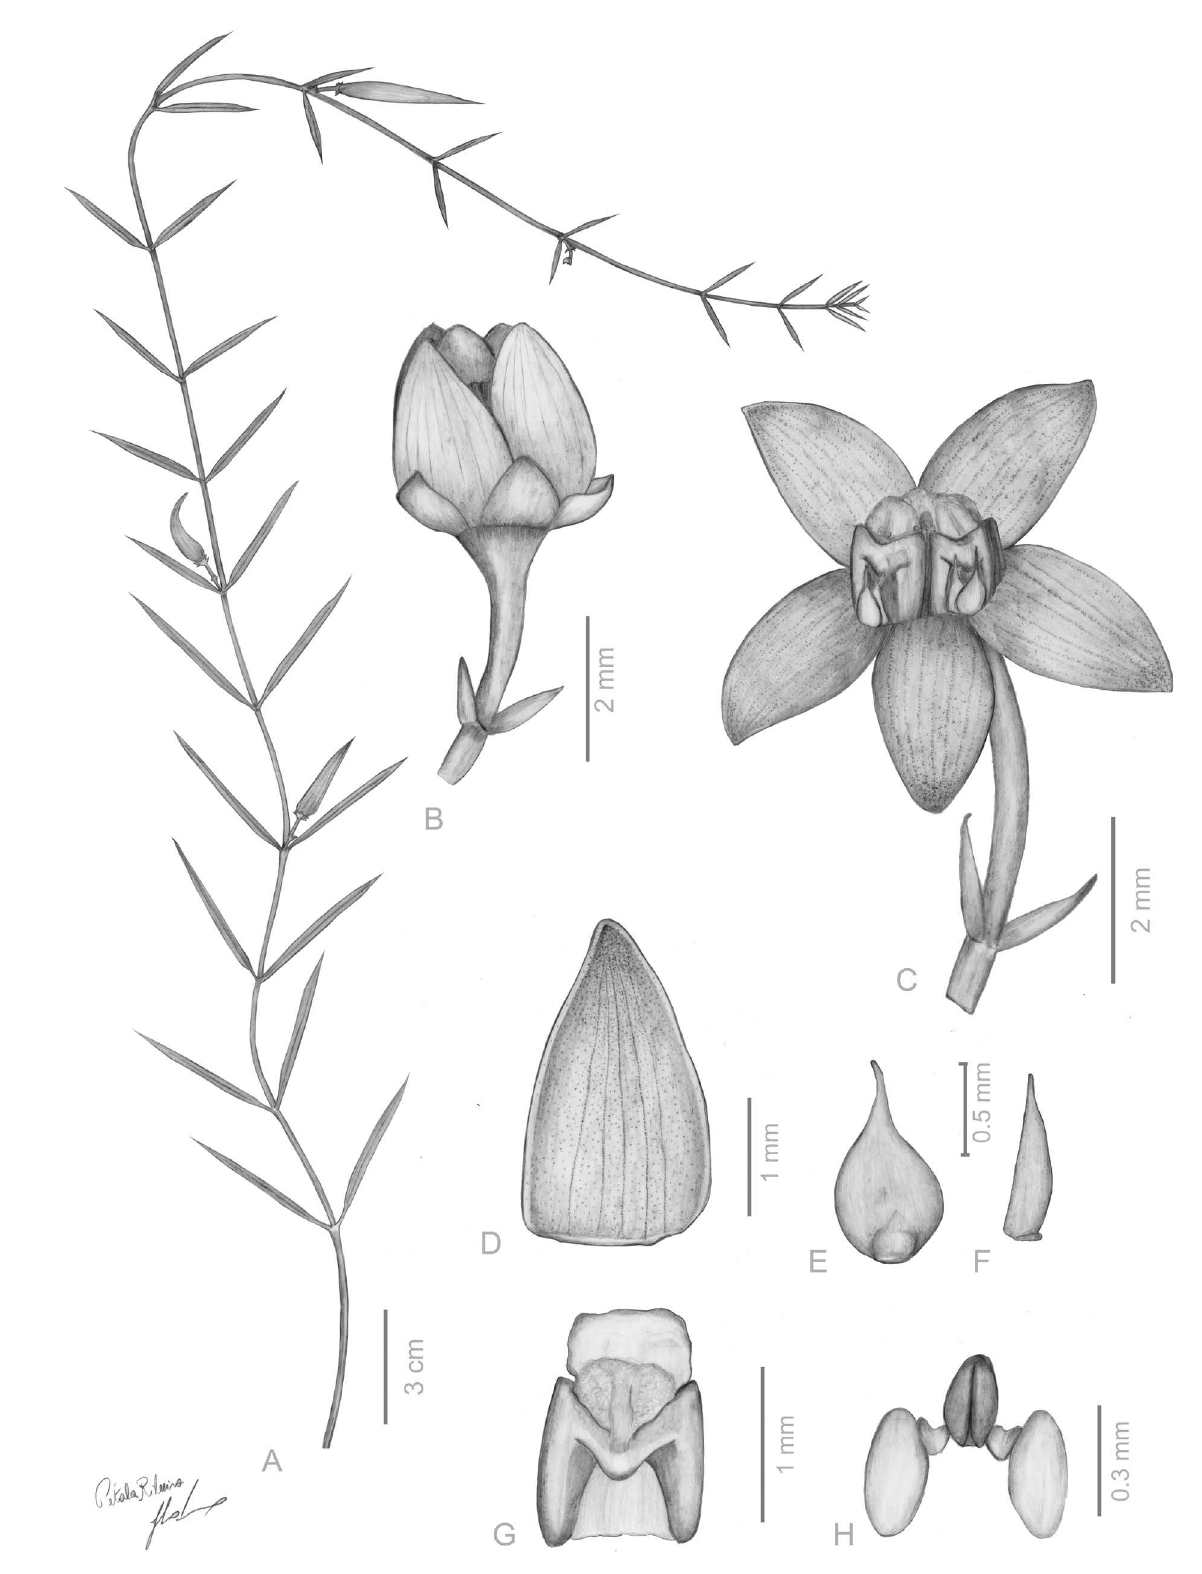
Figure 2 – Ditassa cangae . A . Habit. B . Flower (lateral view). C . Flower, outer lobes of the corona removed to show the gynostegium. D . Corolla lobe (adaxial view). E . Outer lobe of the corona (adaxial view). F . Inner lobe of the corona (adaxial view). G . Anther (abaxial view). H . Pollinarium. Illustration by Pétala Gomes Ribeiro from Carmo 3773